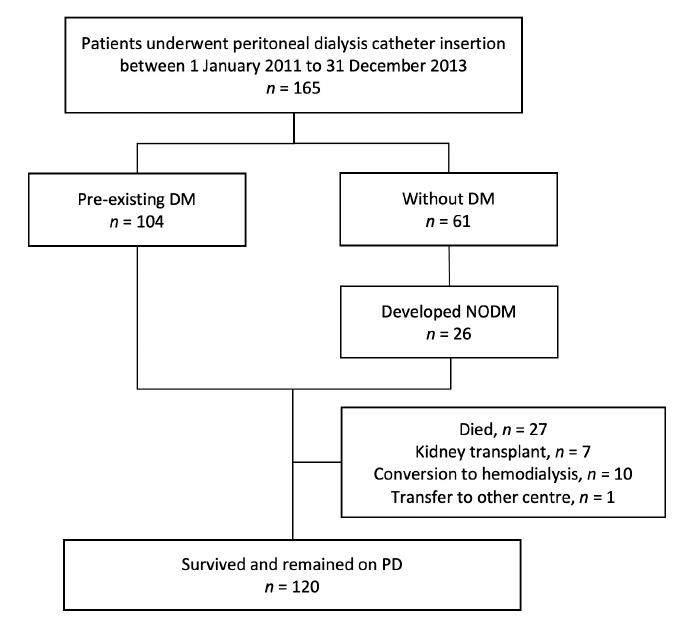
Figure 1. Flow chart. Figure 1. Flow Table 3. Longitudinal change in (A) anthropometry, (B) glycaemic profile, and (C) insulin require- ments.